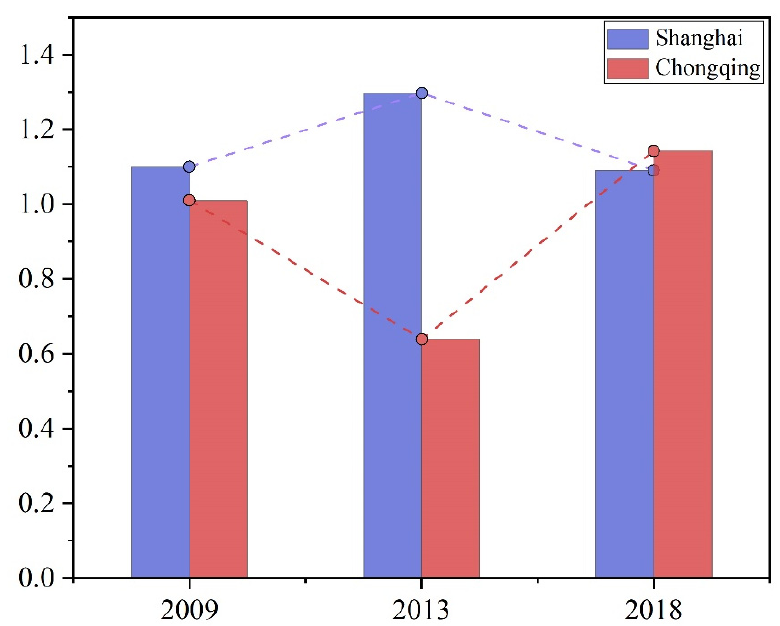
Figure 7. Comparison of agricultural land eco-efficiency between Shanghai and Chongqing.